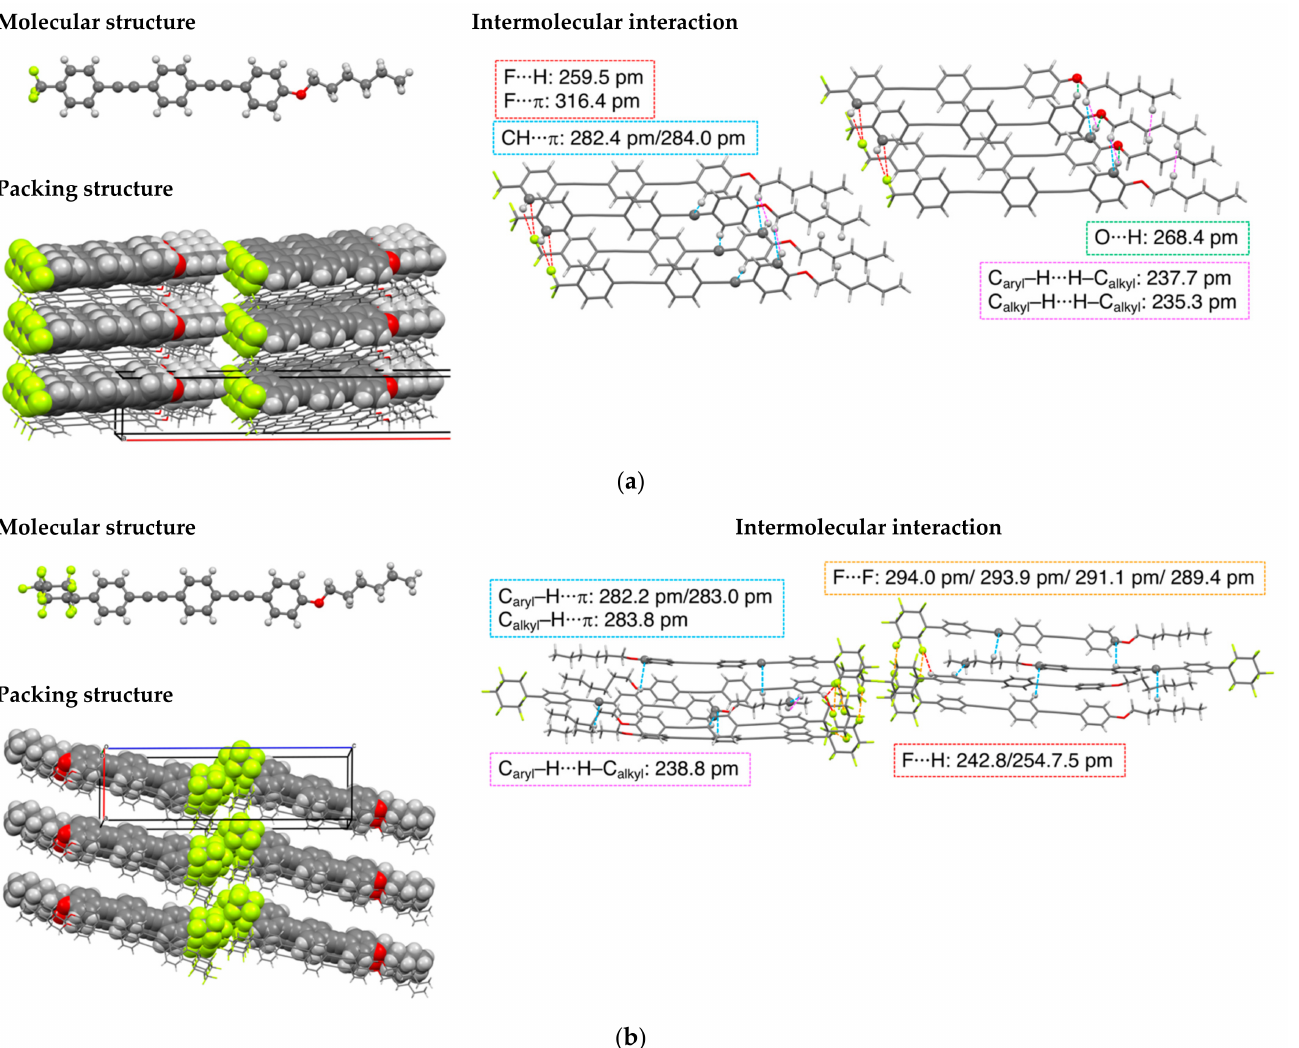
Figure 4. Crystal structures, packing structures, and intermolecular interactions between neighboring molecules for ( a ) 2a and ( b ) 2c